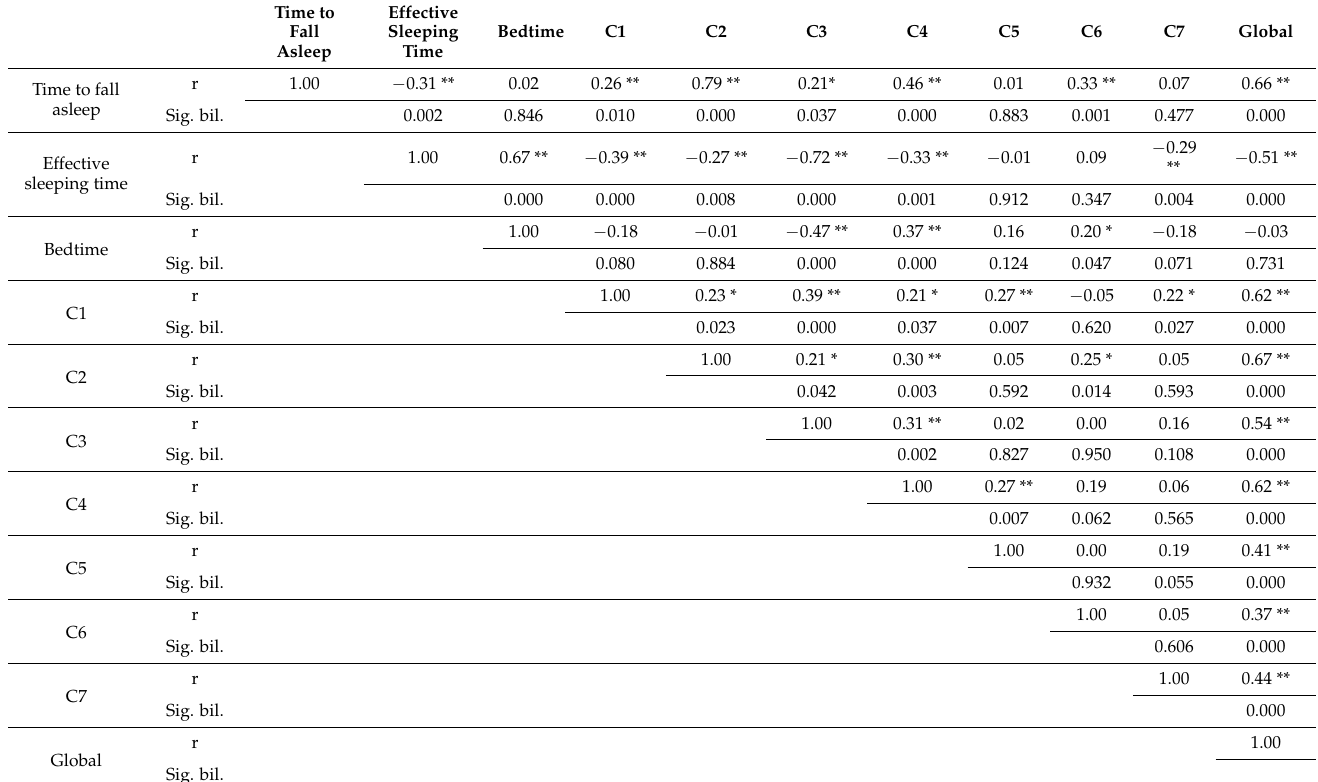
Table 5. Correlations between time and effectiveness of sleep with the PSQI components in Chilean male professional soccer